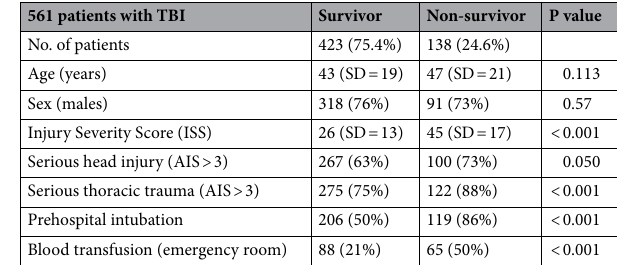
561 patients with TBI